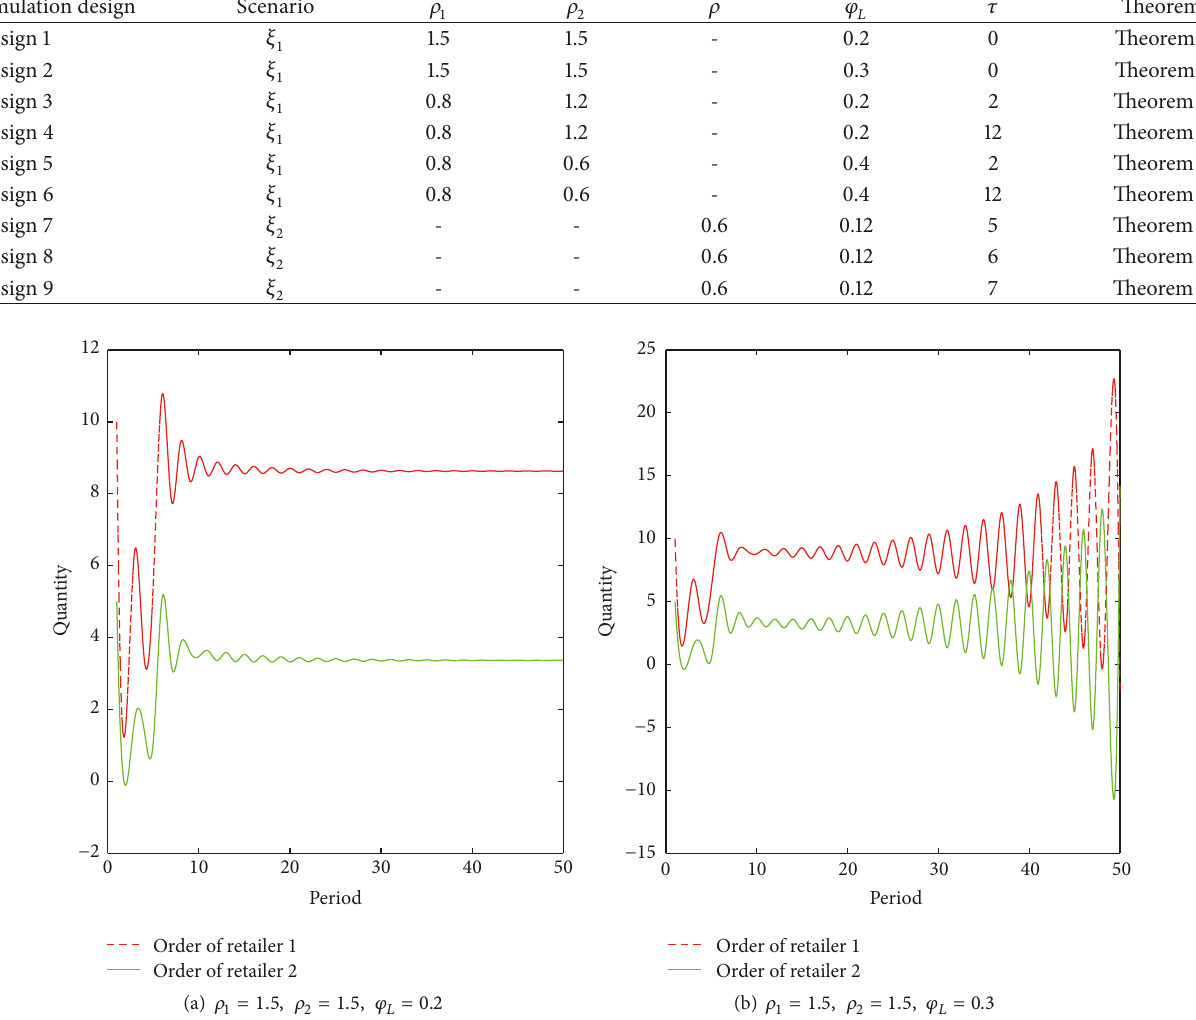
Figure 3: Stability validation for Theorem